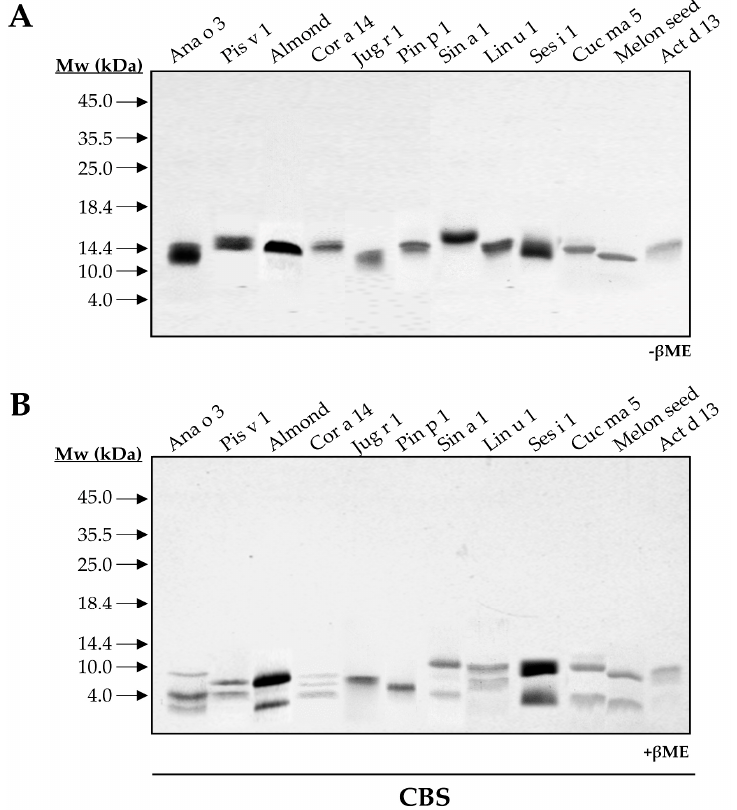
Figure 1. SDS-PAGE of purified 2S albumins from plant-derived sources. Electrophoresis was conducted under non-reducing ( A ) and reducing conditions using β ME ( B ). Molecular mass markers (Mw) are indicated with arrows. CBS: Coomassie Blue Staining.